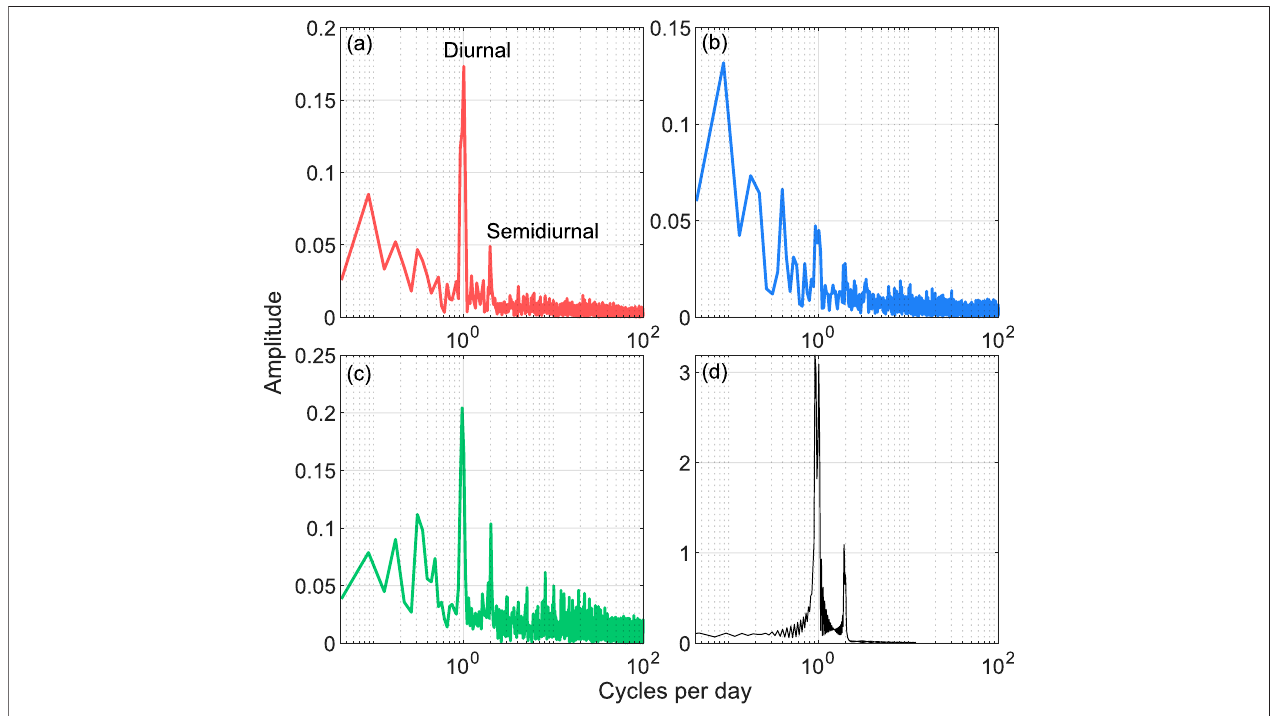
FIGURE 4 | Spectra of the raw GNSS station time series and the modelled tide, computed using the MATLAB fast Fourier transform algorithm. Panel (A) is the across- fl ow position, (B) is the along- fl ow position, (C) is the vertical position, and (D) is the tide prediction.